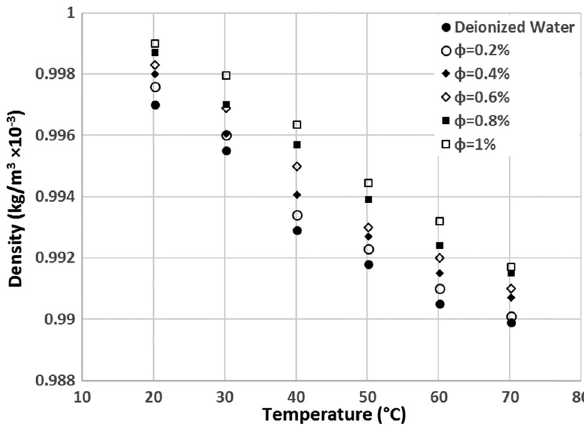
Figure 4: Density measurement of CuO – Cu nano fl